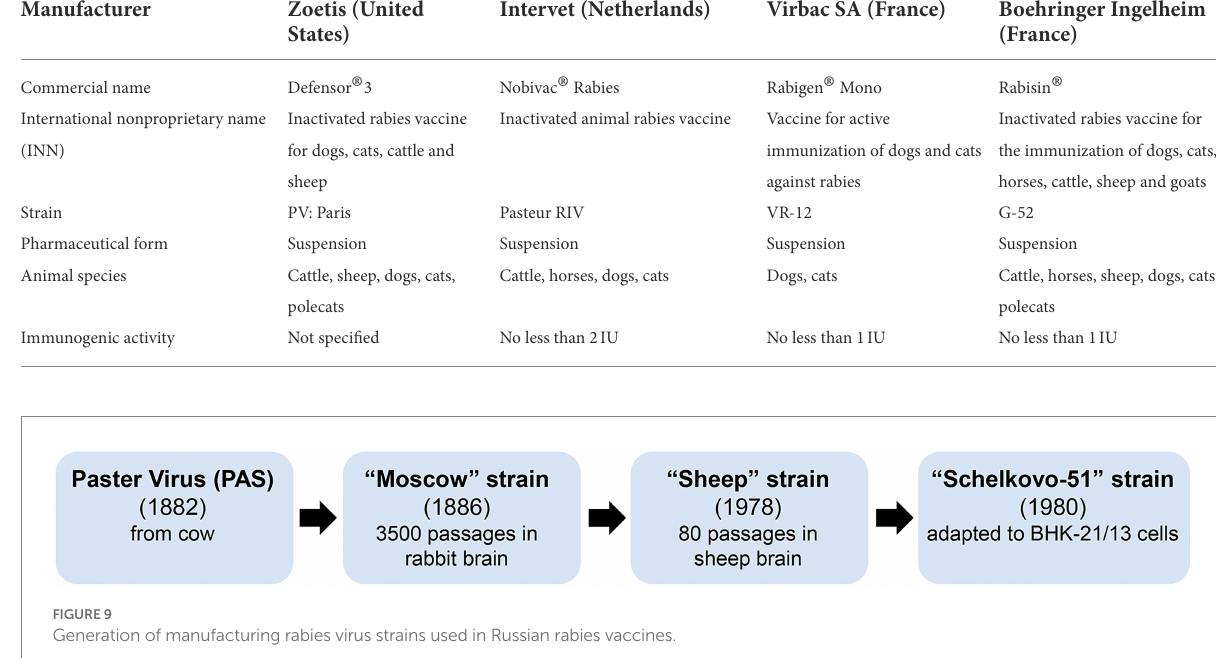
TABLE 4 Summary of characteristics of current rabies vaccines. Manufacturer